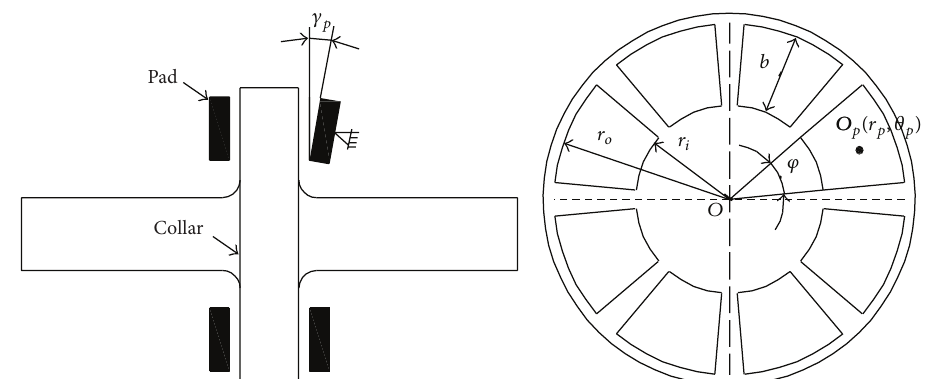
Figure 4: Schematic diagram of thrust bearing.